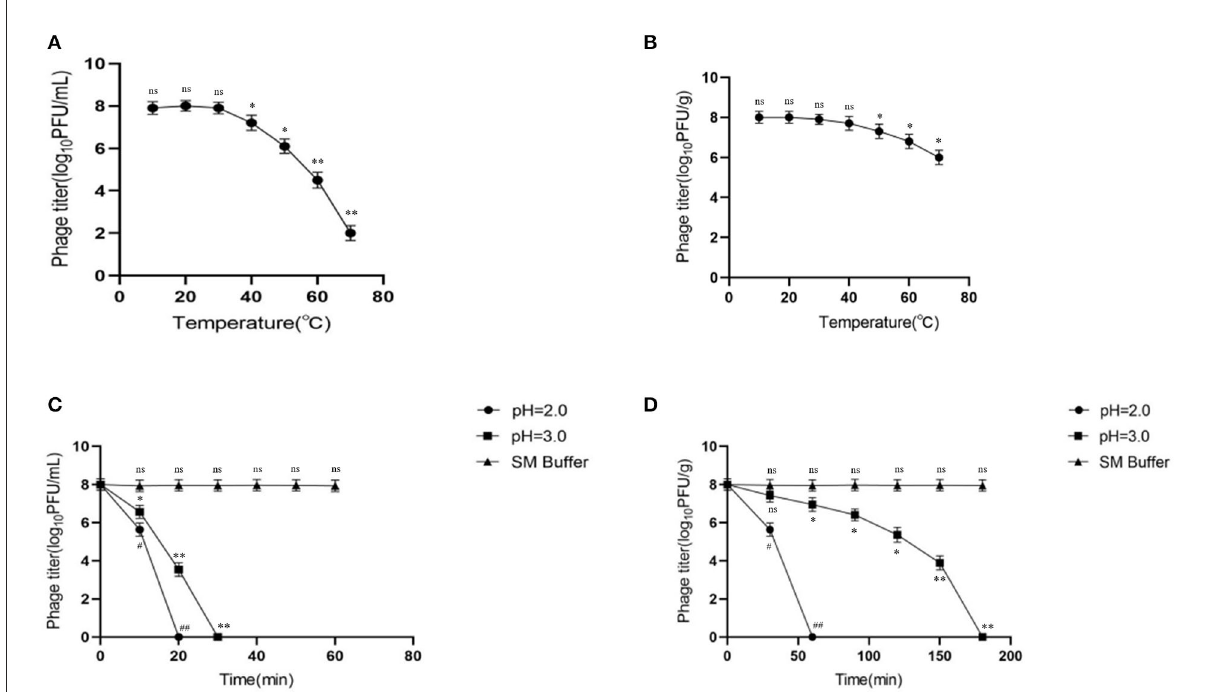
FIGURE2 Stability of microencapsulated phage at different temperatures and SGF. (A) Effects of different temperatures on free phage. (B) Effects of different temperatures on microencapsulated phage. (C) The effect of SGF on free phage. (D) The effect of SGF on microencapsulated phage. ns represents significantly the same ( P > 0.05); *represents significantly the different ( P < 0.05); **represents significantly the different ( P < 0.01); # represents significantly the different ( P < 0.05); ## represents significantly the different ( P < 0.01). Each value in the figure represents the mean ± SD ( n =